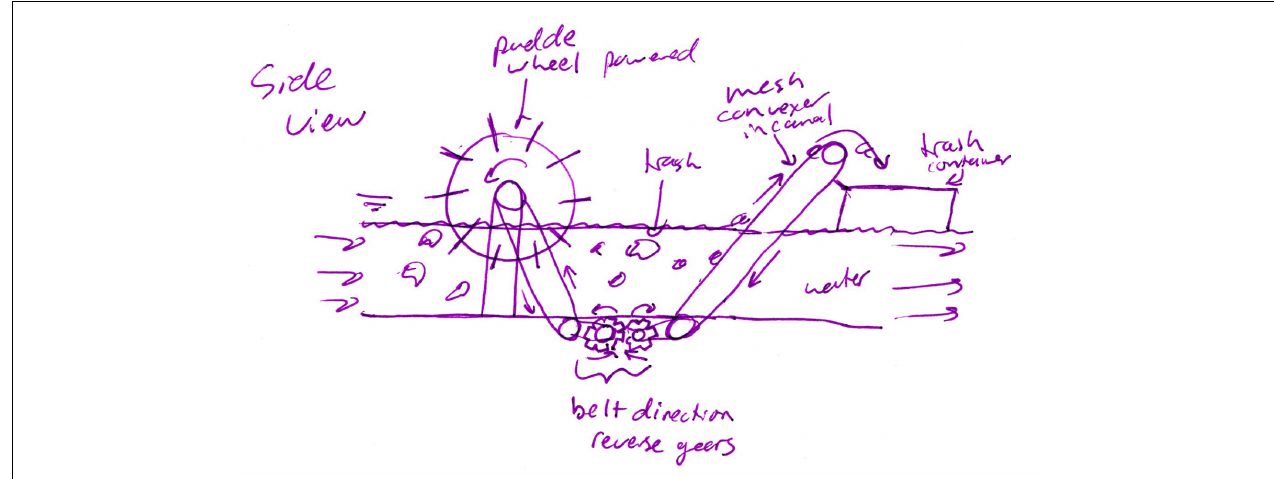
FIGURE 9 | A picker with a suction cup end that received a low originality score but a high novelty score.